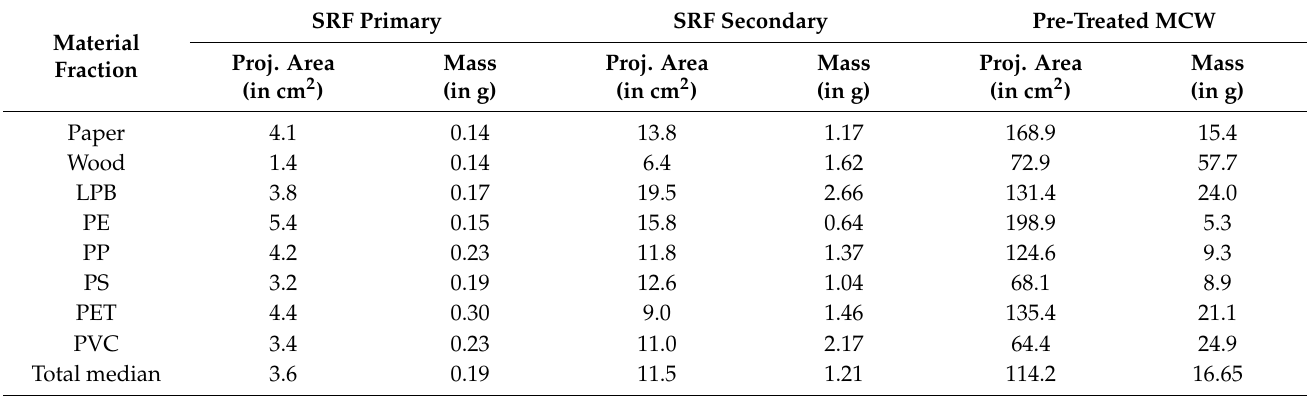
Table 5. Median of the projected area and particle mass, classified according to particle size classes and material fraction [13,60,63].